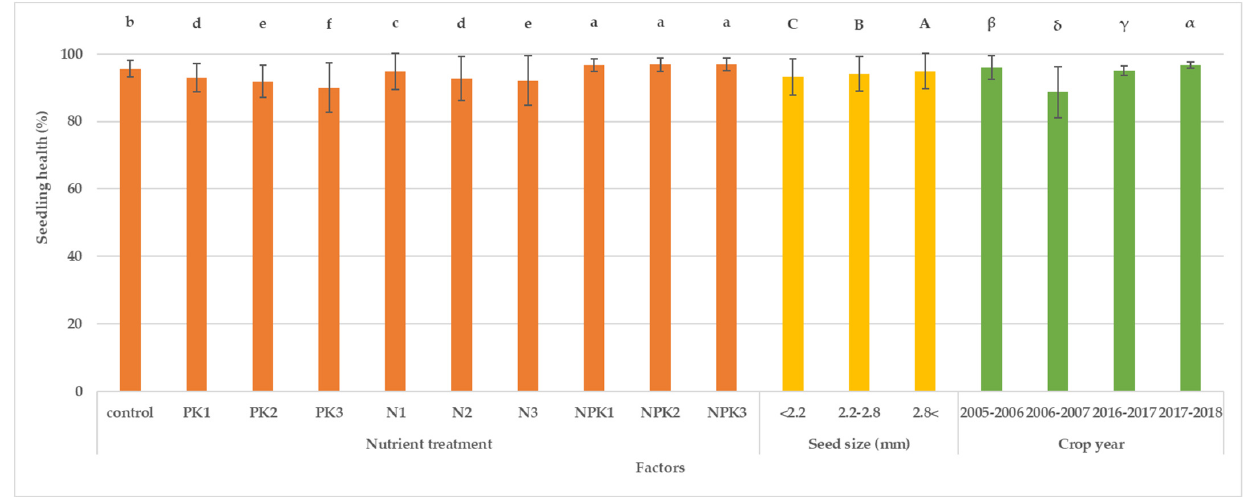
Figure 3. Effect of nutrient treatments, seed size and crop year on seedling health of winter wheat. (Values marked with different letters are significantly different at the p < 0.05 significance level. Small letters (a–f) represent nutrient treatments, capital letters (A–C) represent seed sizes and Greek letters ( α – δ ) represent years, where the order of the letters starts from the largest value. The standard deviation (SD) has been marked in the columns.)